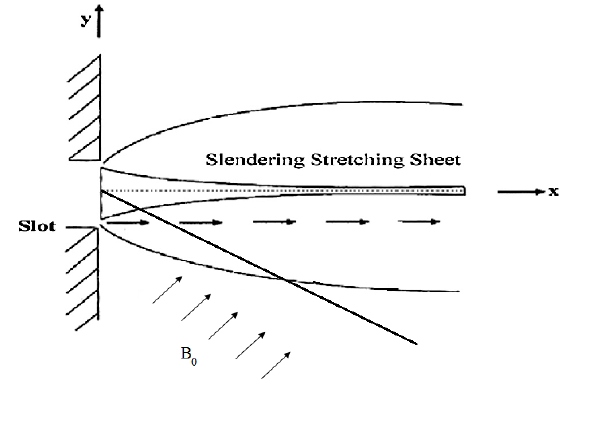
Fig. 1: Physical Model